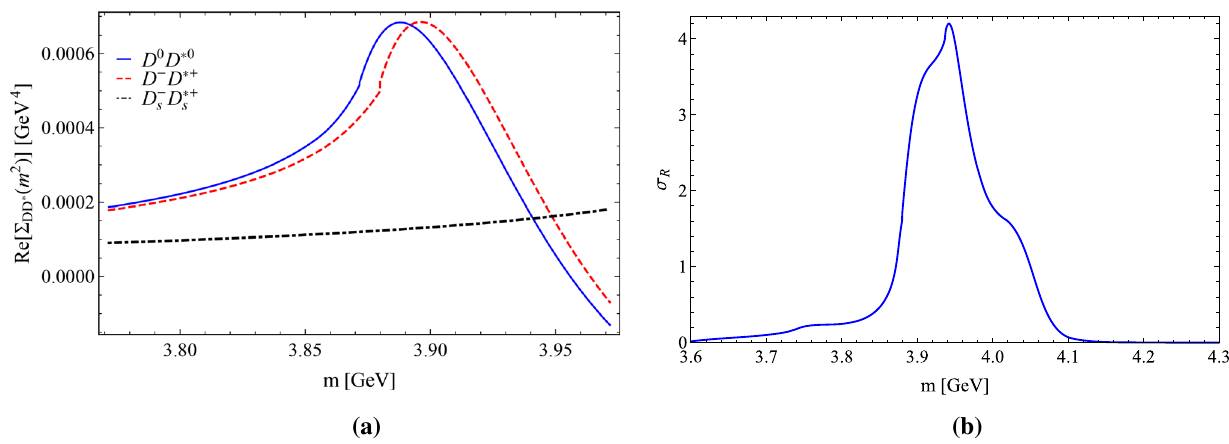
Fig. 5 Left panel: Re (cid:14) D 0 D 0 ∗ and Re (cid:14) D +∗ D − as function of m . Both of them have a peak at about 3 . 9 GeV. Right panel: Plot of the (normalized) cross-section σ R ( m ) of the channel e + e − → ψ( 4040 ) → J /ψπ + π − defined in Eq. (41). A deformed and broad structure with a peak at about 3.95 GeV is